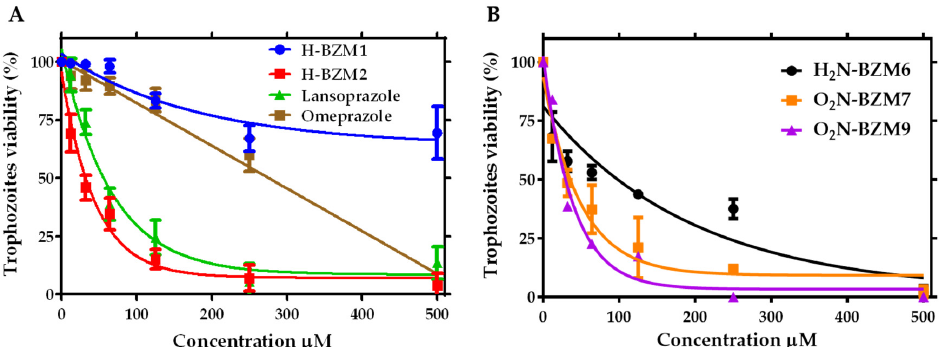
Figure 3. Antigiardial activity of the five novels synthesized compounds and lansoprazole on G. lamblia trophozoites’ viability. The trophozoites were incubated in the presence of ( A ) H-BZM1 , H-BZM2 compounds, and lansoprazole ; ( B ) H 2 N-BZM6 , O 2 N-BZM7 , and O 2 N-BZM9 compounds by 48 h at 37 °C with increasing concentrations of each of the compounds, and later the viability of the trophozoites were determined. The values represent mean ± standard deviation from three independent experiments, standard errors were lower than 5%. Table 1. In vitro antigiardial activities of compounds, and the cytotoxic activity on Caco-2 and HT29 cells.